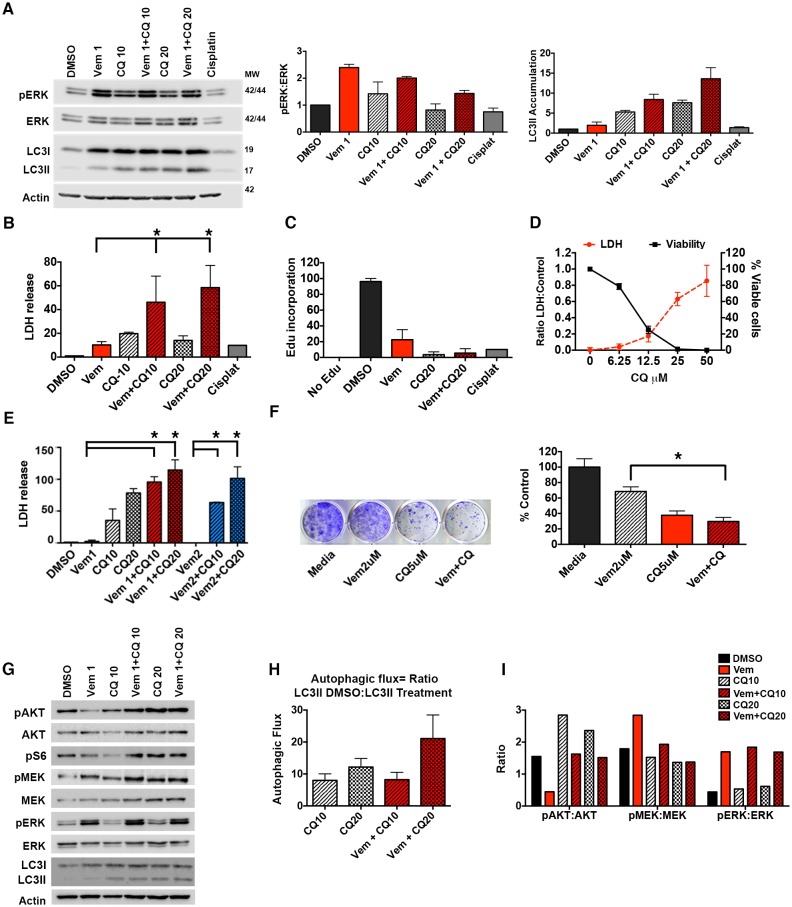
Autophagy inhibition improves clinically acquired BRAFi resistance.(A) Ex vivo slice culture of Patient #1 tumor showing up-regulation of pERK:ERK and inhibition of autophagic flux as indicated by LC3II accumulation by Western blot with quantification of triplicate samples, mean ± s.e.m, n = 3. (B) Cumulative LDH release and (C) EdU incorporation as a measure of cytotoxicity and decreased cell proliferation in Patient #1 treated slice culture samples; One way ANOVA; mean ± s.e.m. *p<0.05. (D) In vitro cell line derived from Patient #1 showing retained response to pharmacologic inhibition of autophagy with decreasing viability and contrasting increase in LDH release with increasing doses of chloroquine (CQ). (E) LDH release as a measure of cytotoxicity in Patient #1 cell line treated for 72 hr as indicated; vemurafenib (Vem) at 1 or 2 μM, CQ at 10 or 20 μM; Unpaired two-tailed Student’s t-test; mean ± s.e.m, n = 3. (F) Long-term growth assay of Patient #1 cell line following autophagy inhibition (CQ), BRAFi (Vem), or combination therapy. Quantified collated data for triplicate experiments. Unpaired two-tailed Student’s t-test; mean ± s.e.m, n = 3. *p<0.05. (G) Western blot analysis of pAKT, AKT, pS6, pMEK, MEK, pERK, ERK, LC3I and LC3II in Patient #1 slice culture samples. Actin included as loading control. (H) Quantification of slice culture samples showing accumulation of LC3II in the presence of CQ as a measure of autophagic flux (mean ± s.e.m, n = 3). There was no significant difference of autophagic flux between the treatment groups. (I) Quantified densitometry ratios of phosphorylated proteins to total proteins shown in (G) for AKT, MEK, and ERK.DOI:
http://dx.doi.org/10.7554/eLife.19671.01410.7554/eLife.19671.015Figure 6—source data 1.Western quantifications, LDH and survival data.(A) Densitometry quantification of Western blotting of slice culture samples. (B) Normalized LDH measures of Patient #1 slice culture samples. (C) EdU quantification by flow cytometry of Patient #1 slice culture samples. (D) LDH and cell viability of Patient #1 cell line treated with increasing doses of CQ. (F) Quantification of long-term clonogenic growth assays in Patient #1 cell line treated with vemurafenib, CQ or a combination of the two drugs. (H) Quantification of autophagy flux in Patient #1 slice culture samples. (I) Quantification of phosphorylated to total protein for AKT, MEK and ERK in Patient #1 slice culture samples.